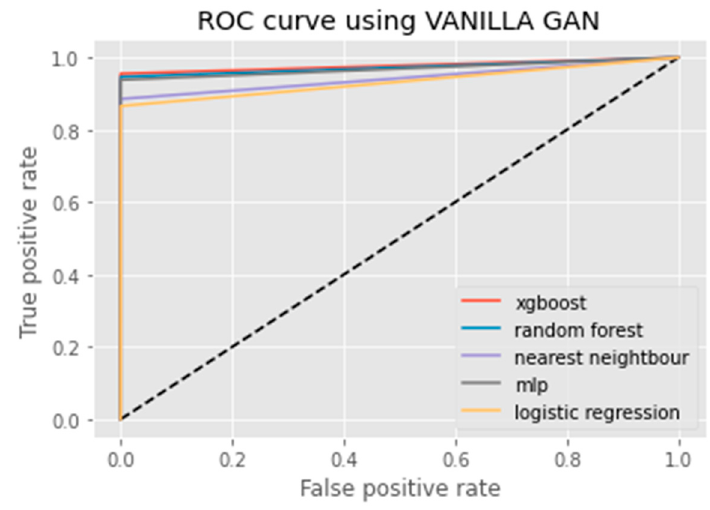
Figure 6. ROC curve using B-SMOTE.